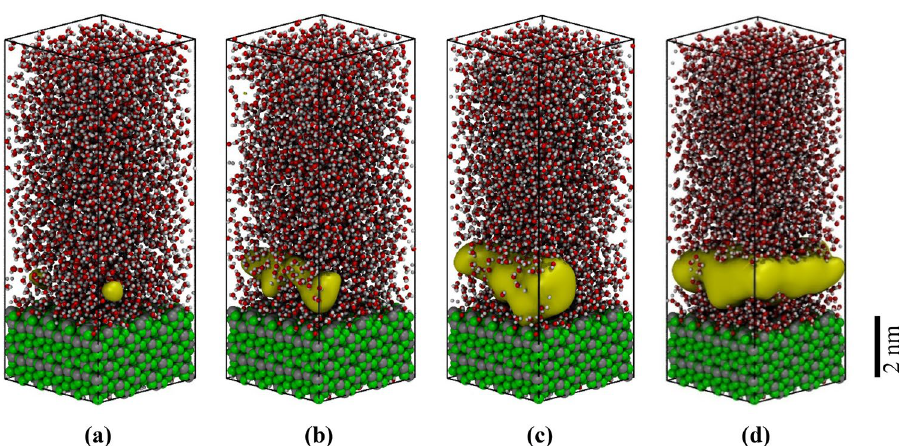
Figure 5. Representation of the initial stage of heterogeneous water nucleate boiling in contact with the hydrophilic (− 111) interface of mZrO 2 . An initial void at distance ~ 7 A from the solid interface nucleates ( a ) which grows ( b,c ) until the formation of a void layer ( d ). See Fig. 1 and 4 capture for further details. Images were created using VMD v1.9.4 47